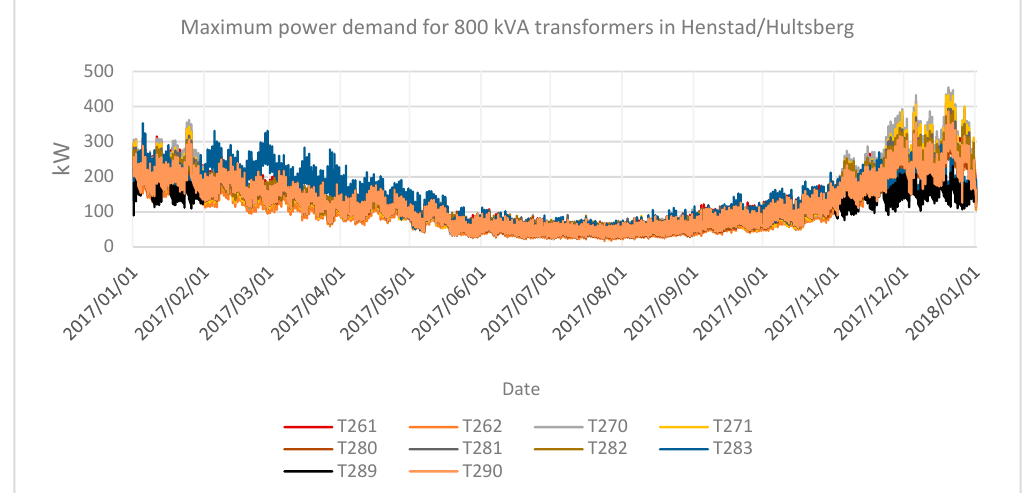
Figure 1. The power demand of 800 kVA transformers.